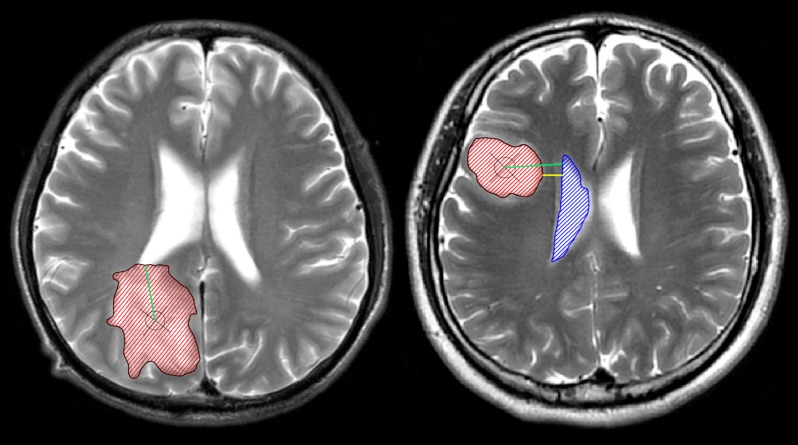
The anatomical relationship between tumors and the subventricular zone (SVZ).The left panel shows a tumor contacting the SVZ; the right panel shows a tumor that is not involved with the SVZ. The manually defined tumor lesions and ventricles are shown as red and blue masks, respectively. The centroid of the tumor is marked with a cross within a circle. The green lines represent the shortest distances from the tumor centroid to the lateral ventricles (CS), while the yellow line represents the shortest distance between the tumor edge and the lateral ventricles (TS). In this study, 143 patients with diffuse astrocytomas were separately grouped by CS/TS, and variables such as survival, age, tumor volume, extent of resection, tumor location, and others were compared among these groups.